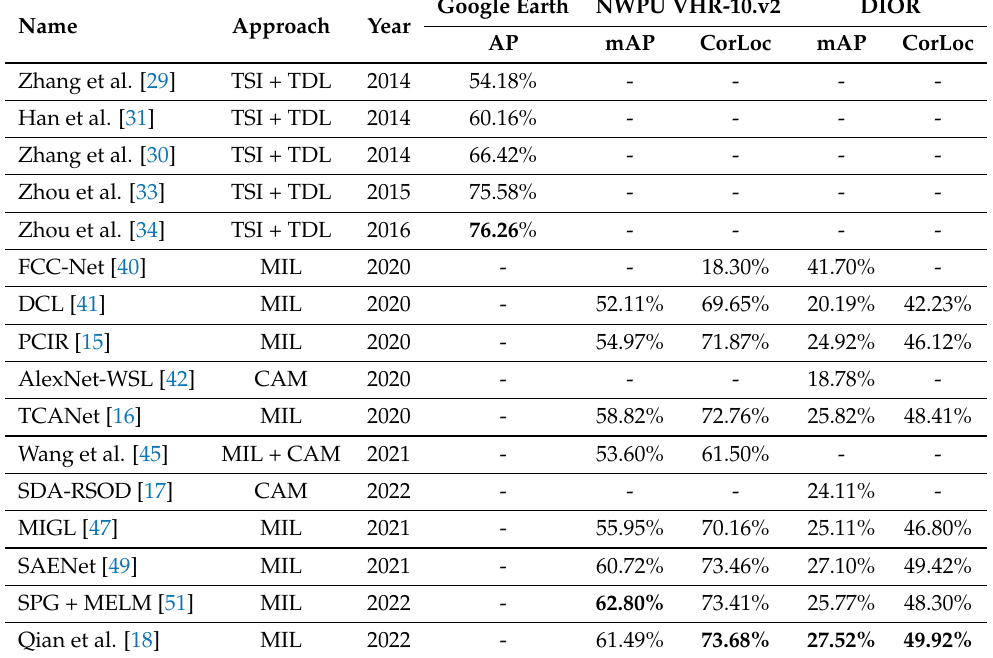
Table 3. Overall results of the methods on the main datasets. Only the methods with available results on DIOR, NWPU VHR-10.v2, or Google Earth are reported. The best performance for each data set is indicated in